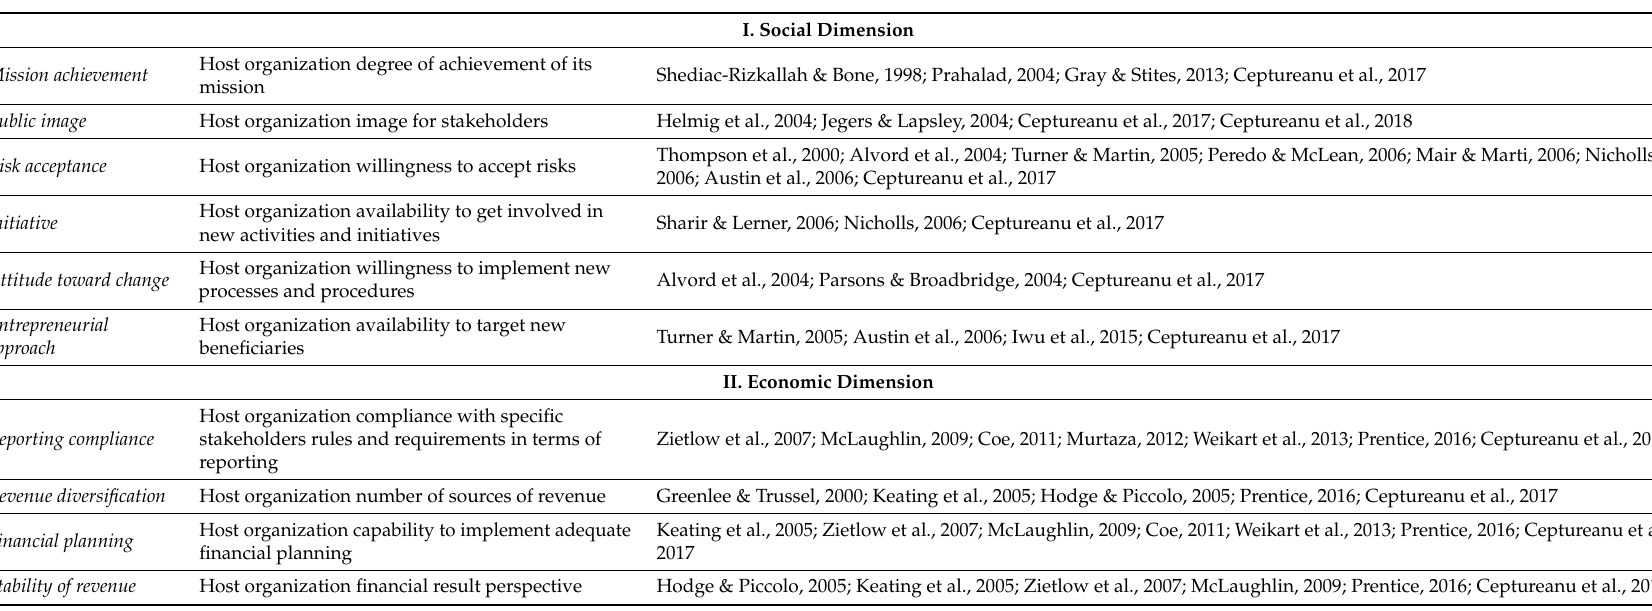
Table 2. Host organization sustainability